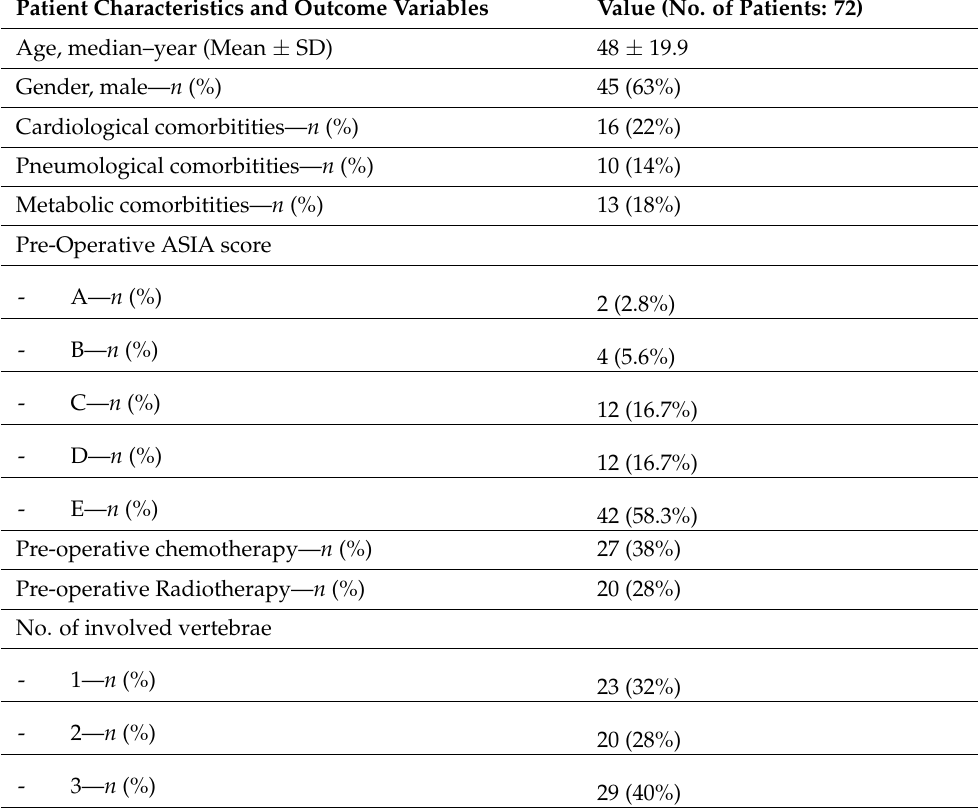
Table 1. Clinical features of the sample based on type of tumor. A remarkable heterogeneity was observed in the sample. Group 1 tumor is defined as mesenchymal primary tumors, group 2 as primary tumors of the lung infiltrating the vertebrae and group 3 as vertebral metastases. Patient Characteristics and Outcome Variables Value (No. of Patients: 72) 48 ±